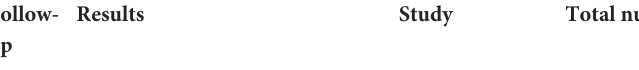
TABLE 3 Results summary on menstrual blood loss